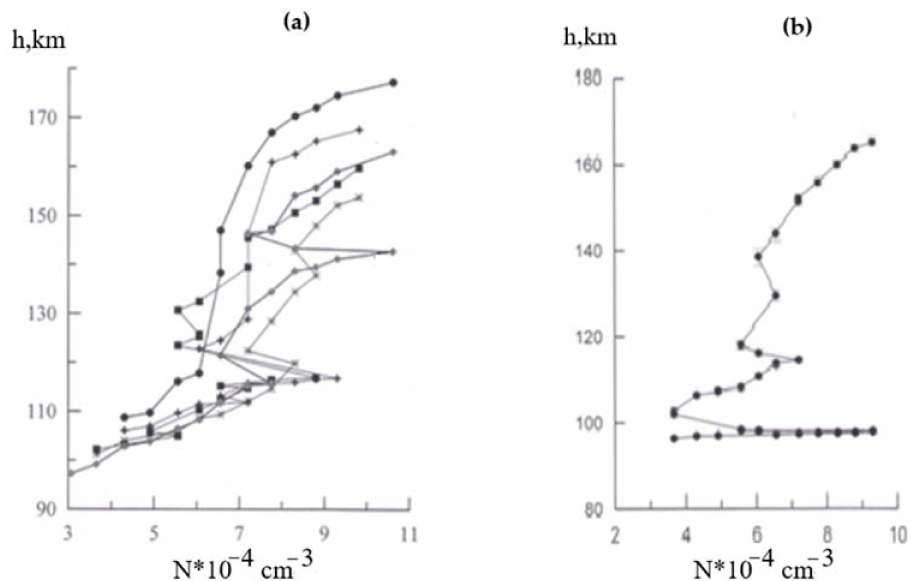
Figure 7. Examples of height profiles of electron density N ( h ) with sporadic E layers and intermediate layers in the E-F valley, obtained by the API technique, for ( a ) 17 December 1999 and ( b ) 4 October